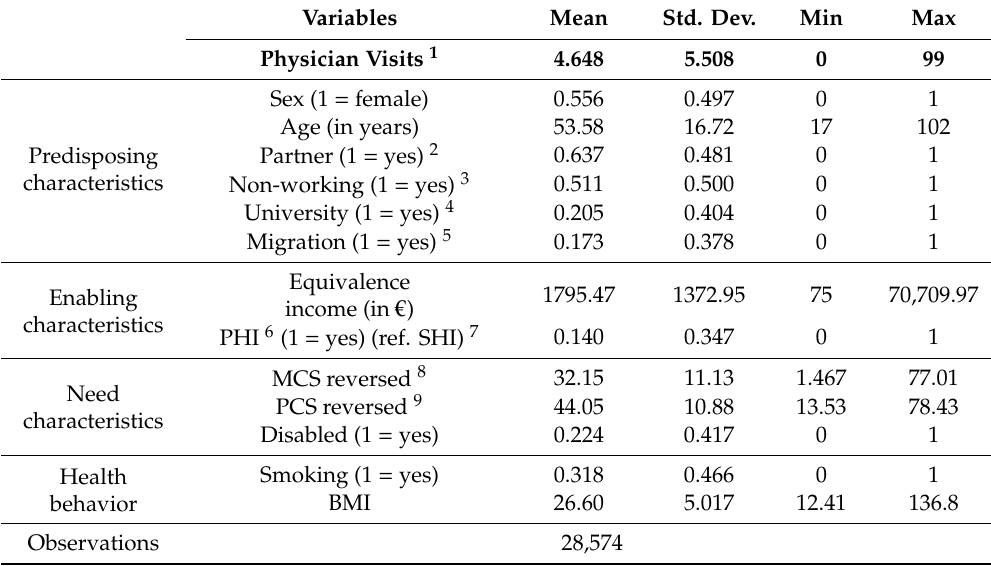
Table 1. Descriptive results (2002–2014